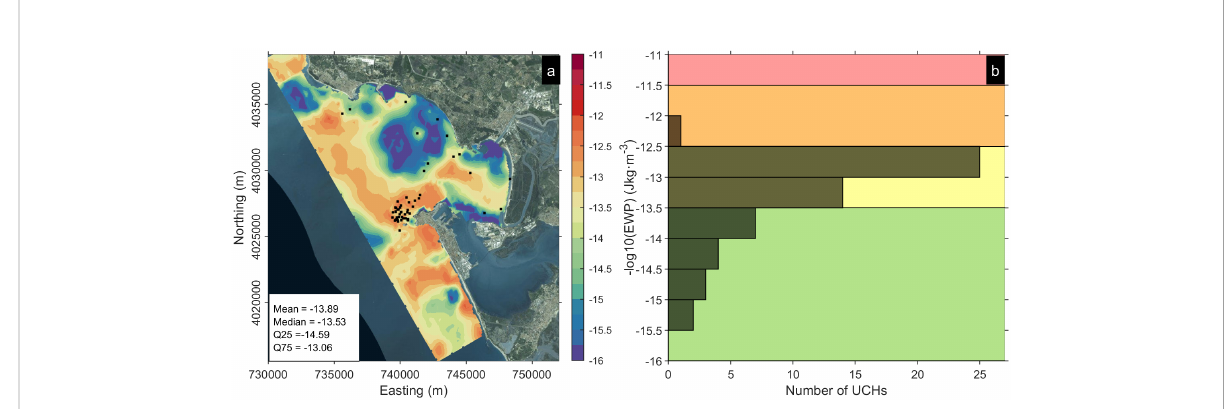
FIGURE 6 (A) Map of erosive wear hazard (log of erosive wear potential) in the outer Bay of Cadiz. (B) Histogram of the hazard at underwater cultural heritage sites and hazard classes (background